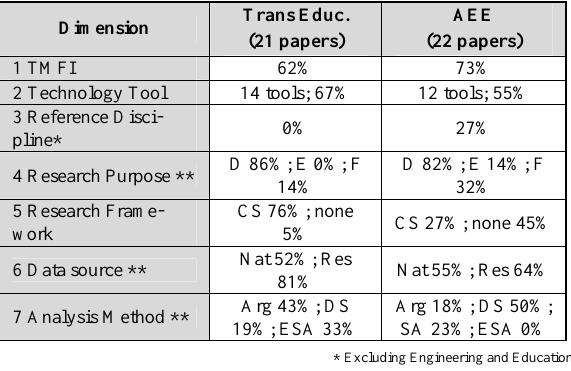
TABLE V. S UMMARY OF THE SEVEN TAXONOMICAL DIMENSIONS FOR THE 2 JOURNALS